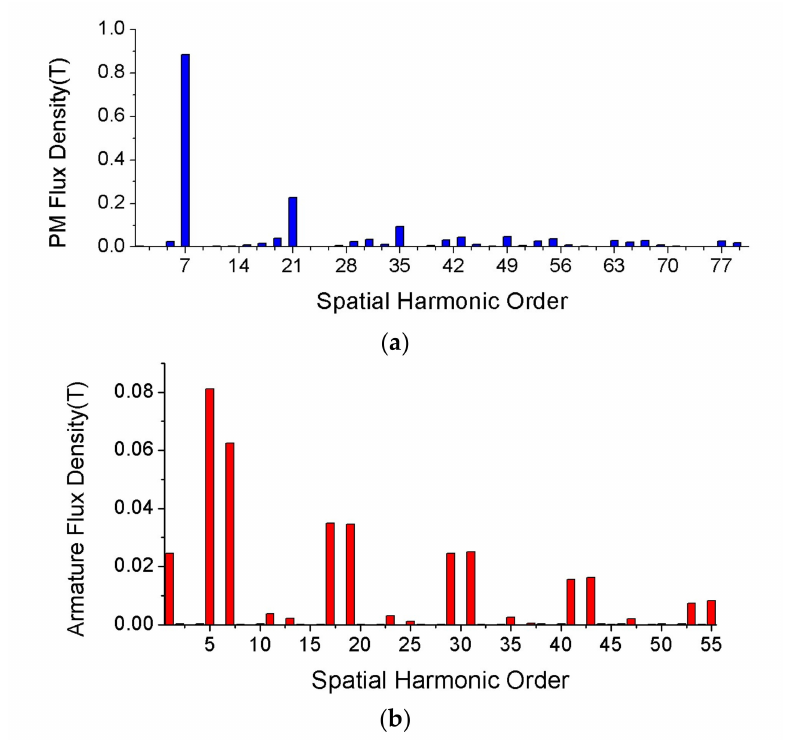
Figure 3. FFT of the PM motor: ( a ) PM flux density. ( b ) Armature flux density.